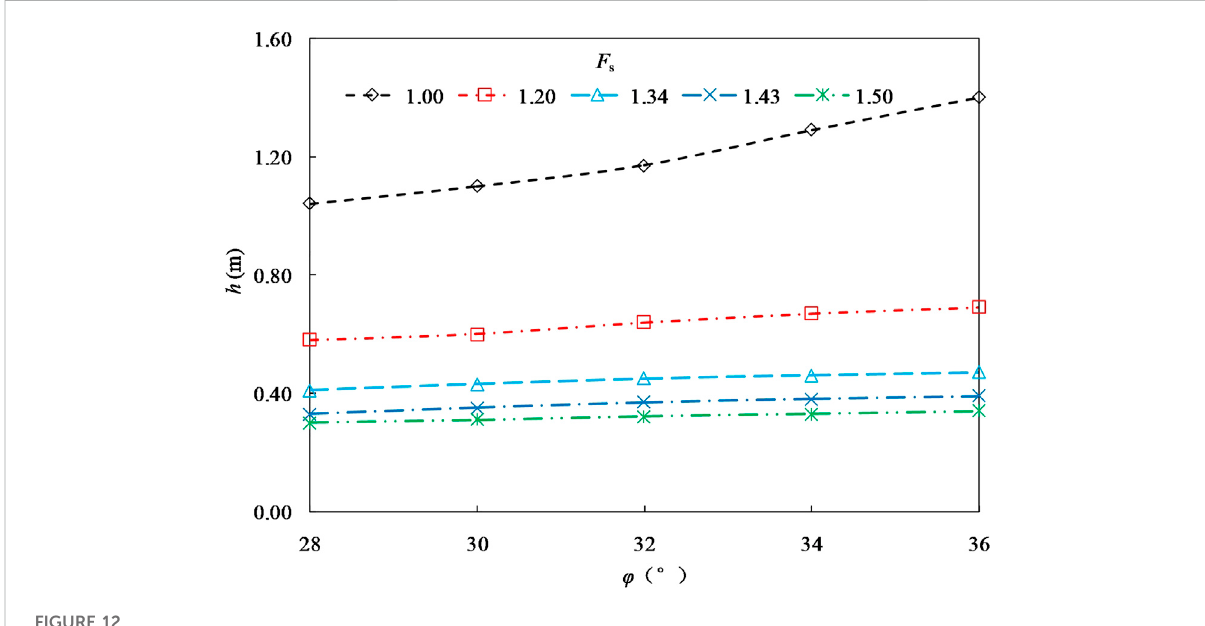
FIGURE 12 Relationship between h and φ under different F s .